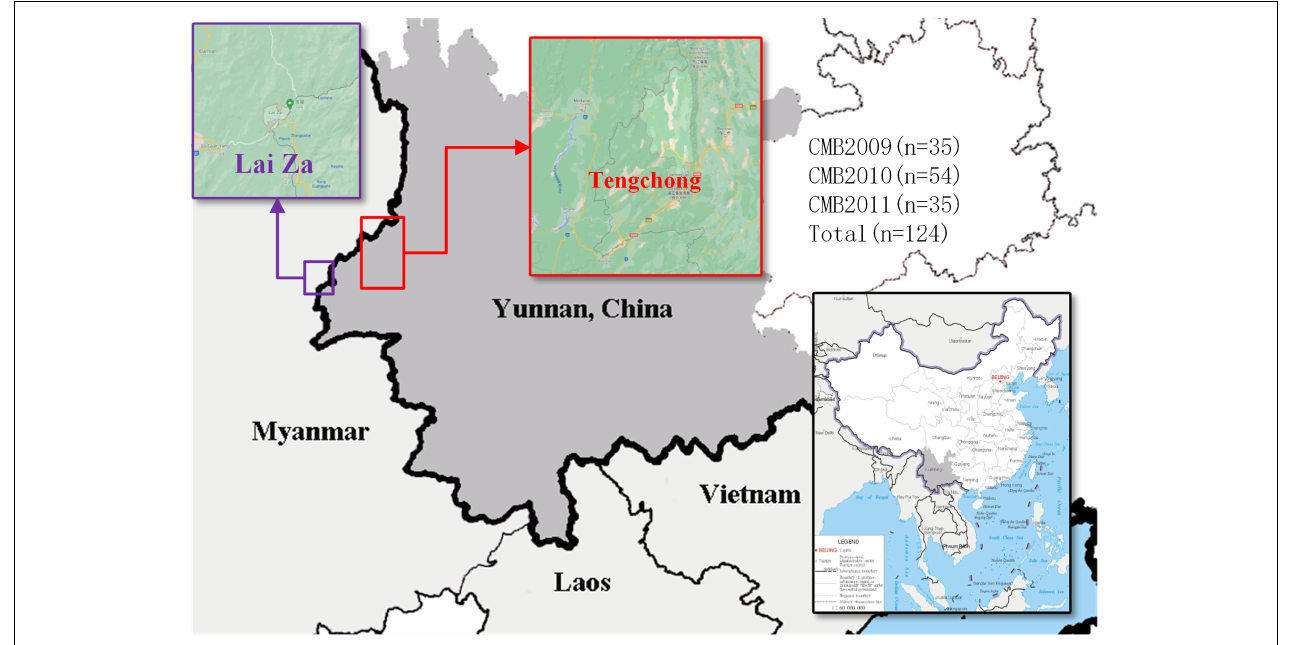
FIGURE 1 | The map of P. vivax samples collection. Samples collection was made in Tengchong, marked in red rectangle (China-Myanmar border in Yunnan Province of